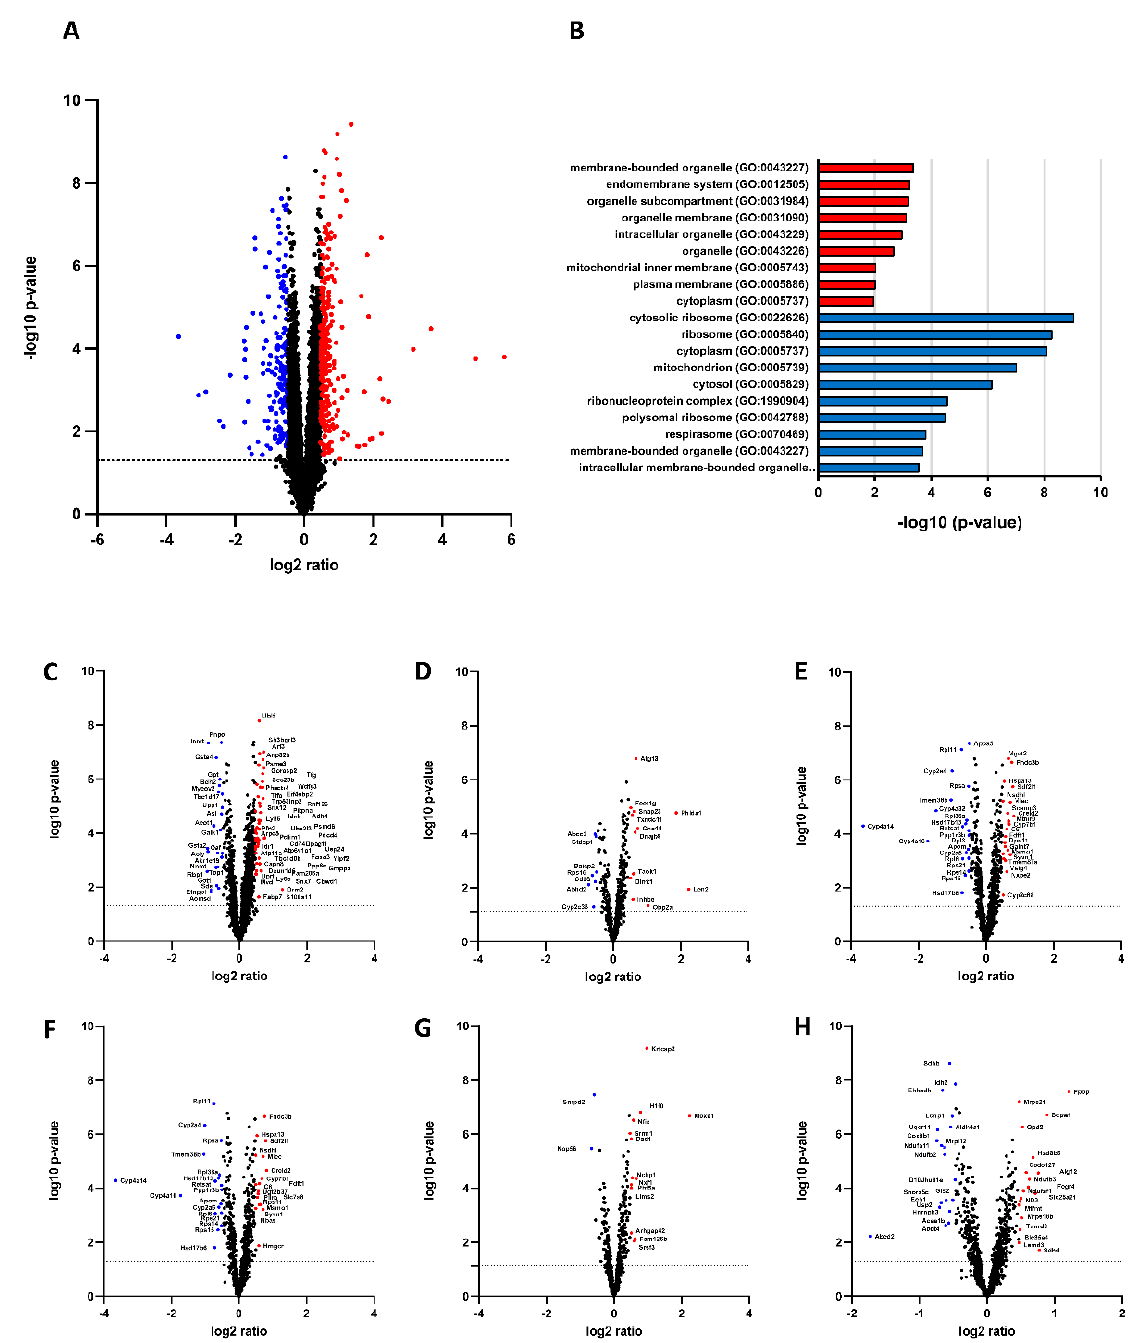
Figure 1. Impact of constitutive overexpression of SREBP-1c on hepatic transcriptome. ( A ) The log2 fold changes of coding and noncoding RNA abundance in alb-SREBP-1c vs. C57Bl6 mice (n = 8 animals per condition). 22,026 differentially abundant RNA species were detected. Upregulated (red; n = 314) or downregulated proteins (blue; n = 191) were determined by Student’s t-test ( p > 0.05) with a 1.5-fold regulation. ( B ) RNA species regulated by alb-SREBP-1c were subjected to functional enrichment analyses. Significantly enriched pathways (FDR < 0.1) are shown for GO biological process ontology. A modified Fisher’s exact test was used for the functional enrichment analyses. P values were corrected for multiple testing using the Benjamini–Hochberg (FDR) method. ( C – H ) Transcriptomic signature of cellular compartments: ( C ) Cytoplasma, ( D ) Plasma membrane, ( E ) Endoplasmic reticulum and Golgi apparatus, ( F ) Endosome and Lysosome, ( G ) Nucleus, ( H ) Mitochondria and Peroxisomes.